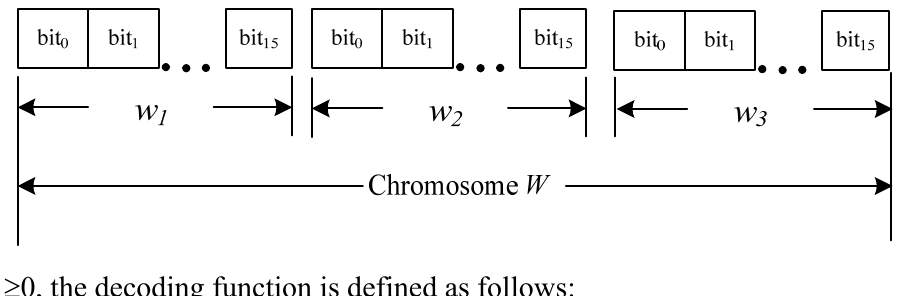
Figure 5. Data structure of